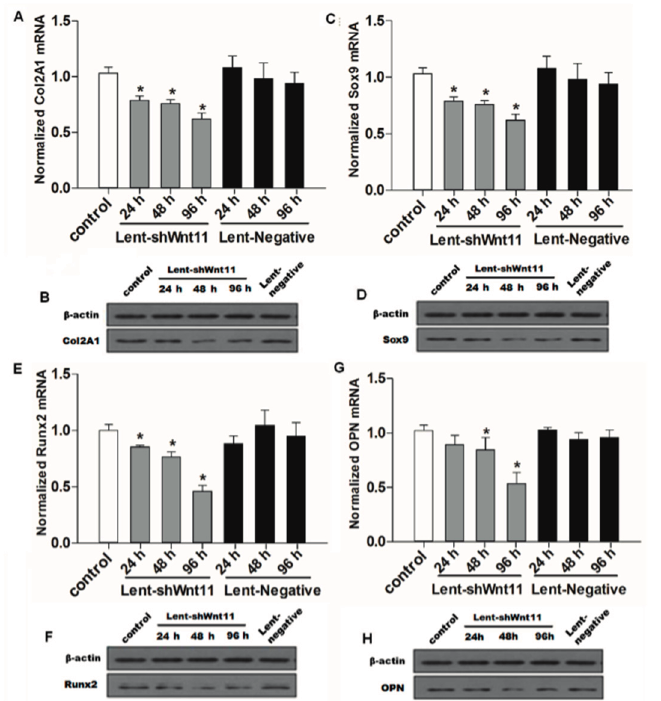
Figure 3. Wnt11 knockdown reversed the potential of the EMT process in PRECs. Quantitative detection for mRNA levels of E-cadherin ( A ); mesenchymal marker Zeb1 ( B ); Snail1 ( C ) in PRECs with Wnt11 knockdown. The data represent the mean ± SD of at least three independent experiments; * p < 0.05 compared with the control. Western blot ( D , E ) showed a similar trend in protein expression levels as in mRNA levels after silencing the Wnt11 gene in PRECs.